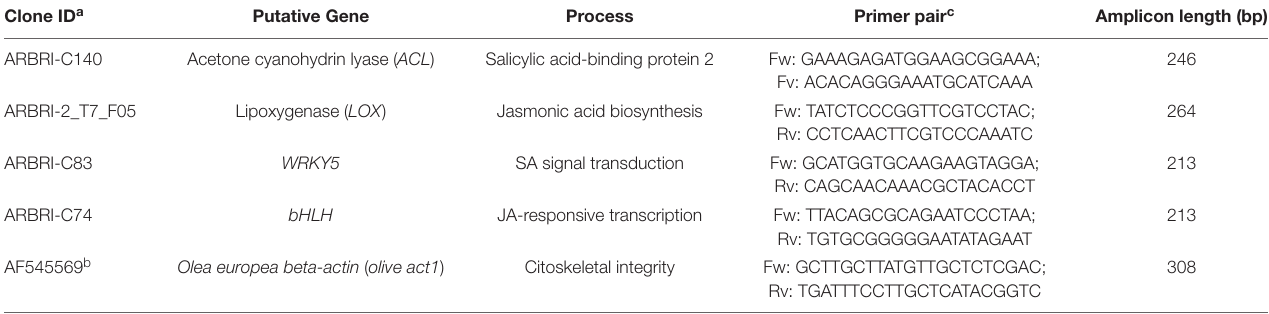
TABLE 1 | Transcripts used in this study. Clone ID a Putative